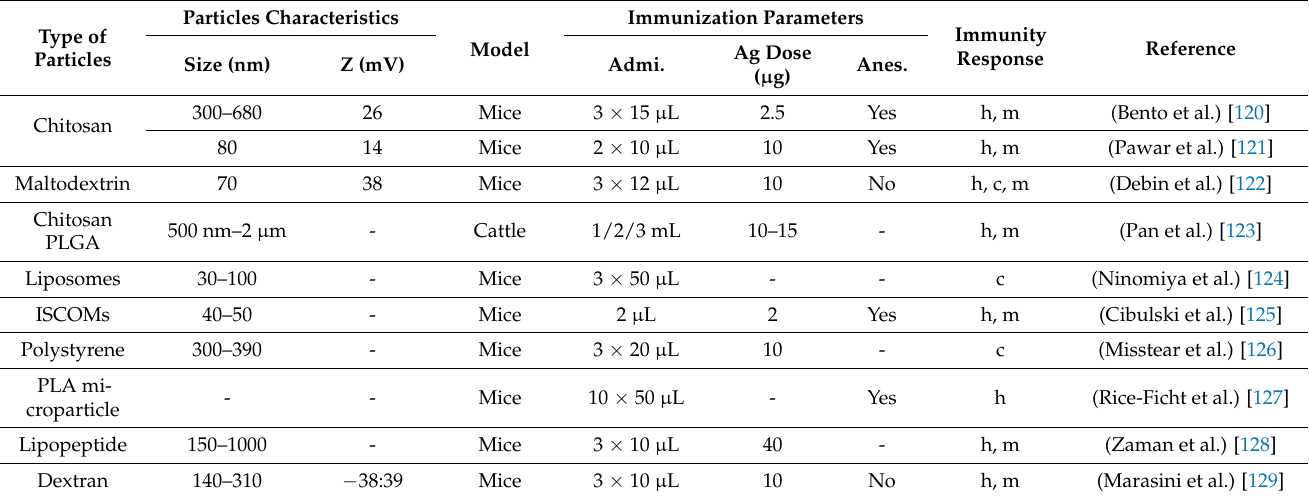
Table 2. Nanoparticles for nasal vaccination, immunization parameters, and immune